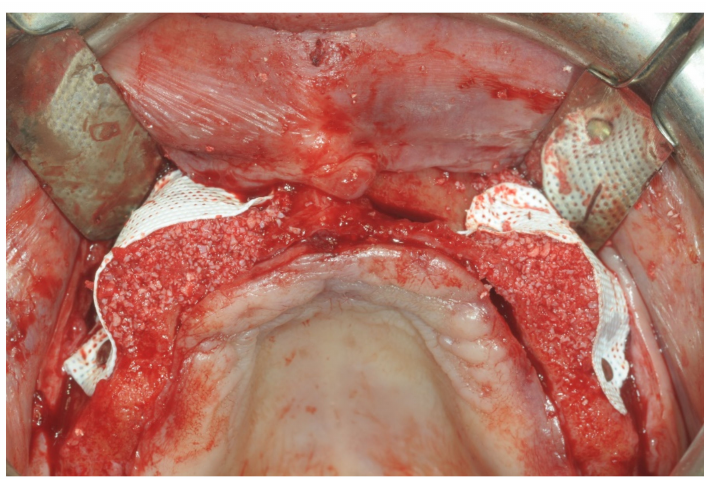
Figure 4. Placement of the graft and of the non-resorbable membranes, fixed with pins.